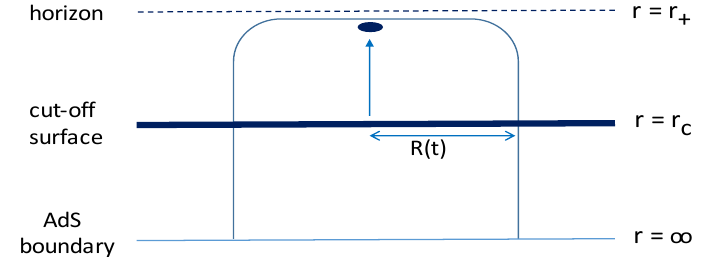
Figure 2 . As a localized wave approaches the horizon, the minimal RT surface that contains the excitation at time t extends along the horizon over a distance R ( t ) that grows linearly in time. This situation is depicted in (cid:12)gure 2. As time passes, the particle falls